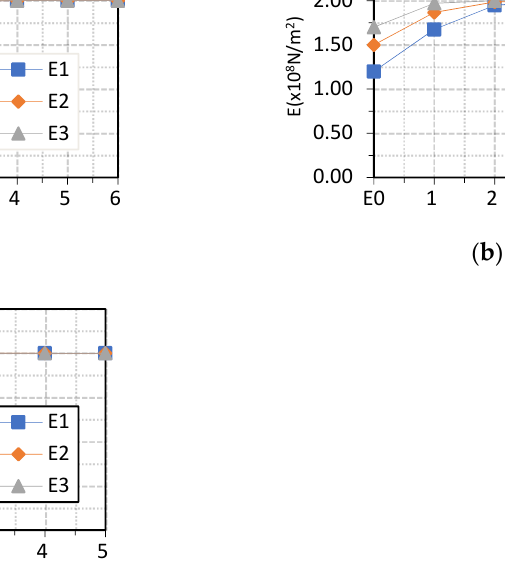
different amounts of strain data from Table 2 as supplementary conditions to conduct the